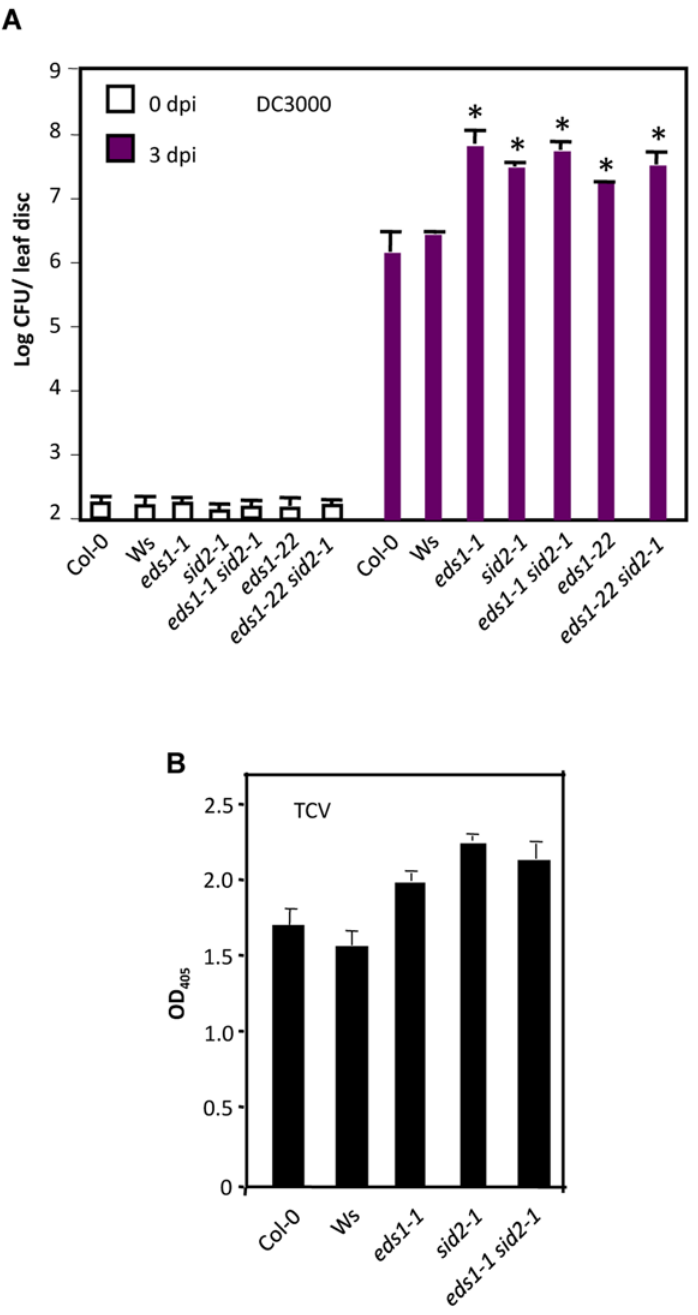
Figure 7. Basal resistance in eds1sid2 plants. (A) Growth of virulent P. syrinage on indicated genotypes. The error bars indicate SD. Asterisks indicate data statistically significant from wt (Col-0 or Ws) (P , 0.05, n=4). The eds1-1 and eds1-22 are in Ws and Col-0 ecotypic backgrounds, respectively. (B) ELISA showing levels of TCV CP in the inoculated leaves of indicated genotypes at 3 dpi. The error bars indicate SD (n=4).